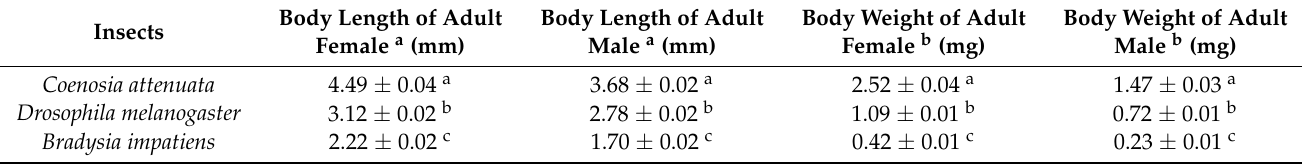
Values are mean ± SE. Means in columns with the same letter are not significantly different at a 0.05 level of significant. a Adult body length measured < 24 h after adult emergence. b Adult body weight measured < 24 h after adult